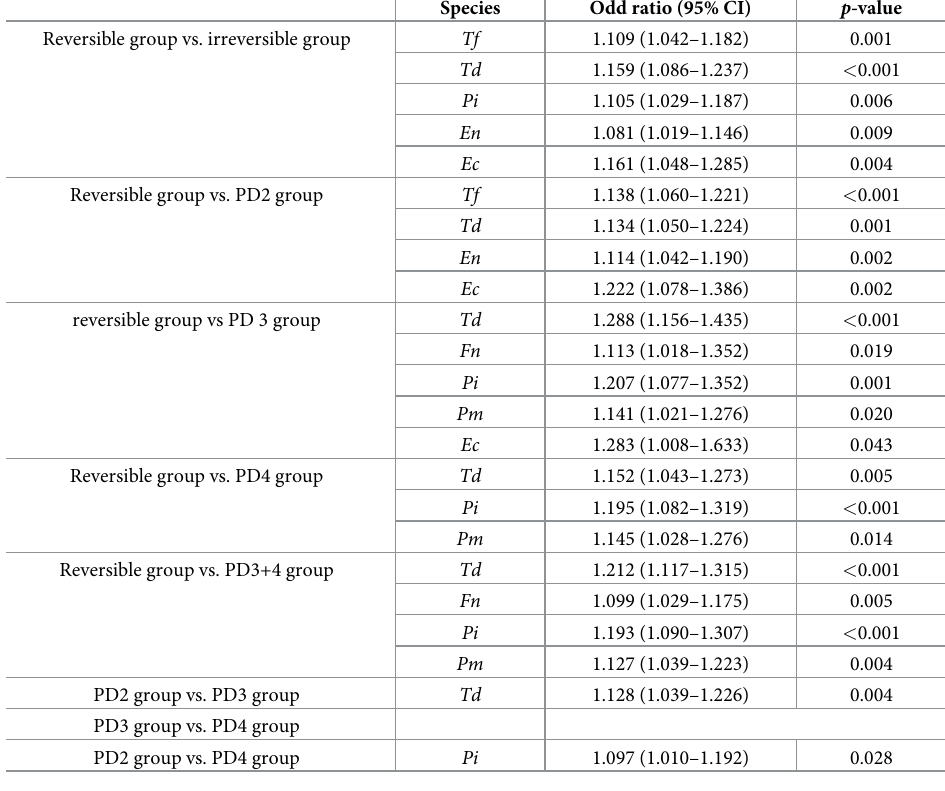
Table 5. Association between the combinatory coexistence and numbers of bacterial species with the periodontal disease